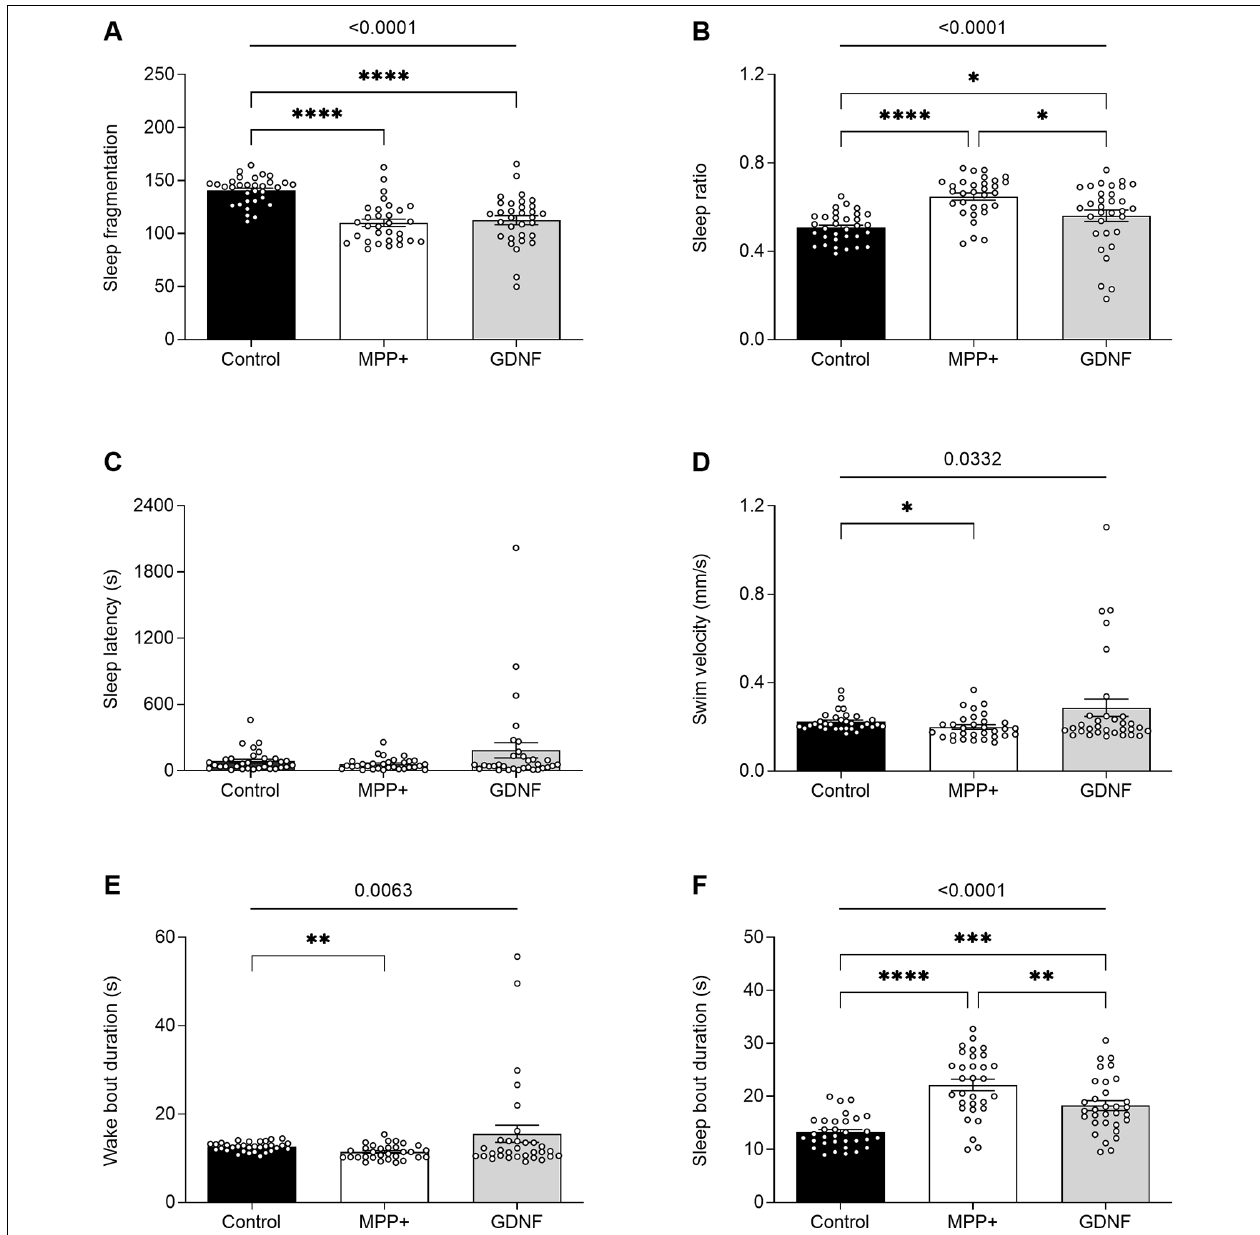
FIGURE 6 | Effects of GDNF on the sleeping pattern of MPP+-treated zebrafish larvae. Larvae were incubated in the absence (black bars) or presence (white and gray bars) of 500 µ M MPP+ and injected with 72.9 ng GDNF (gray bars) at 4 dpf before assessing (A) sleep fragmentation; (B) sleep ratio; (C) sleep latency (s); (D) swim velocity (mm/s); (E) wake bout duration (s) and (F) sleep bout duration (s) at 6 dpf. Data are presented as means ± SEM from a single experiment, control group n = 32, MPP+ group n = 31, GDNF group n = 32. Normality was tested using D’Agostino and Pearson omnibus normality test followed by the two-tailed Kruskal–Wallis test ( p -value shown above graph) and Dunn’s post hoc analysis. ∗∗∗∗ p < 0.0001, ∗∗∗ p < 0.001, ∗∗ p < 0.01, ∗ p < 0.05, for multiple